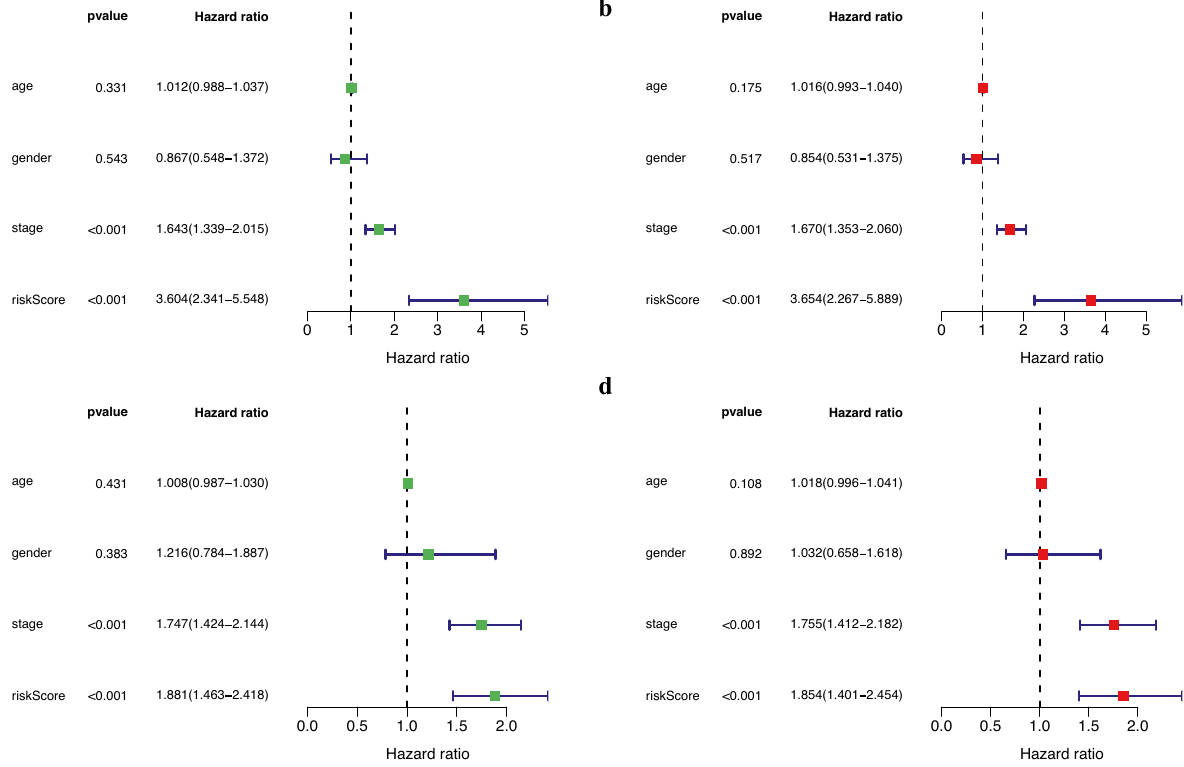
Figure 3. Evaluation of the independent prognostic ability of the risk scoring model. ( a ) Results of univariate COX regression of risk scores with clinical information in the training set. ( b ) Results of multi-factor COX regression of risk scores and clinical information in the training set. ( c ) Results of univariate COX regression in the test set. ( d ) Results of multifactor COX regression in the test